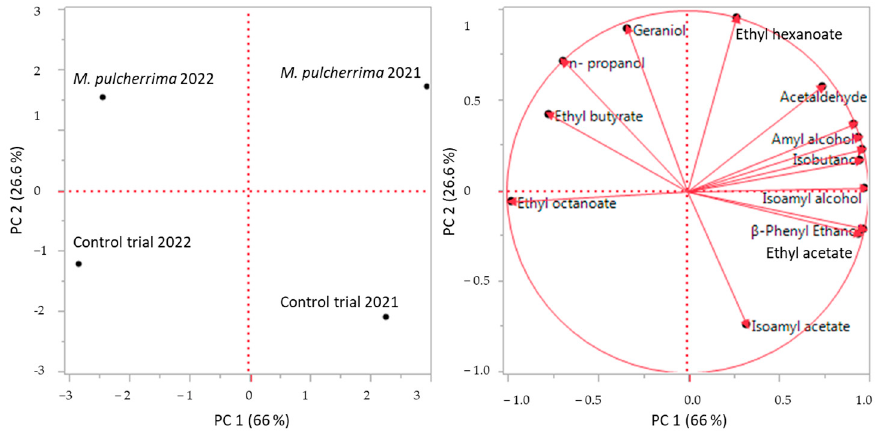
Figure 3. Principal component analysis of the main volatile compounds in wine coming from two consecutive vintages. The variance explained by principal component analysis (PCA) is PC 1 66% X-axis and PC 2 26.6% Y-axis.